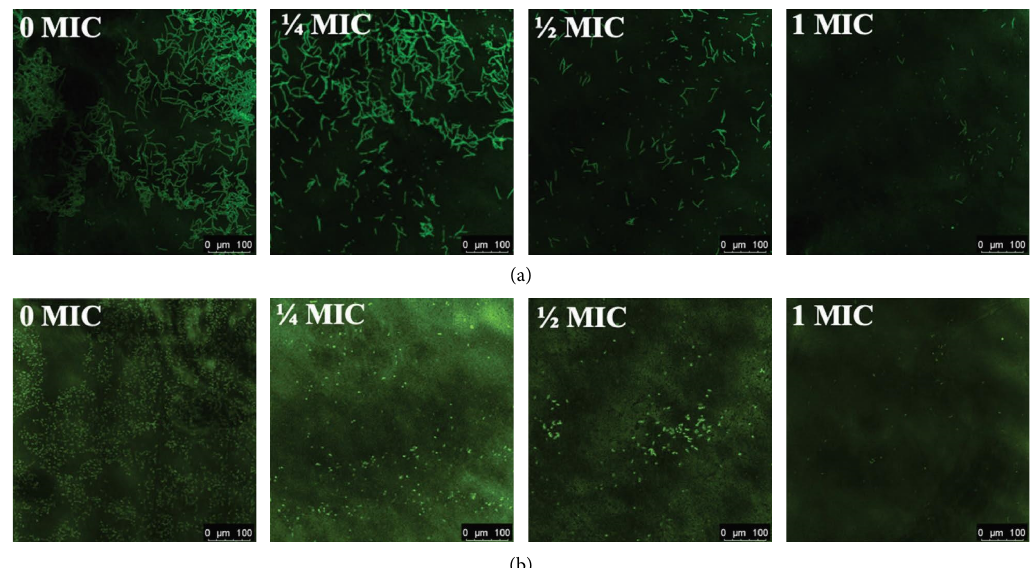
Figure 6: CLSM images of bioflms by A. sobria (a) and S. saprophyticus (b) after KA treatment at diferent densities at 30 ° C for 24